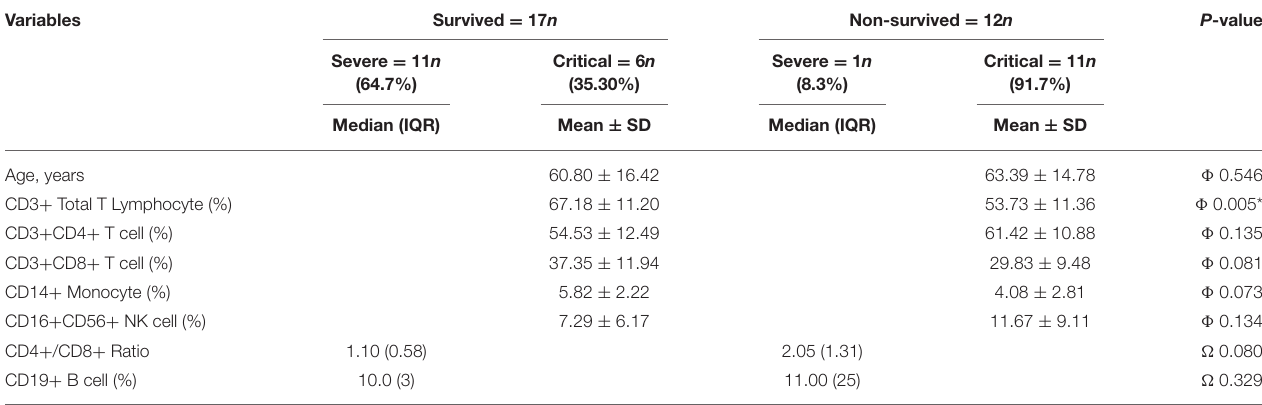
TABLE 5 | Comparison of peripheral innate and adaptive immune cells of COVID-19 survived patients with non-survived